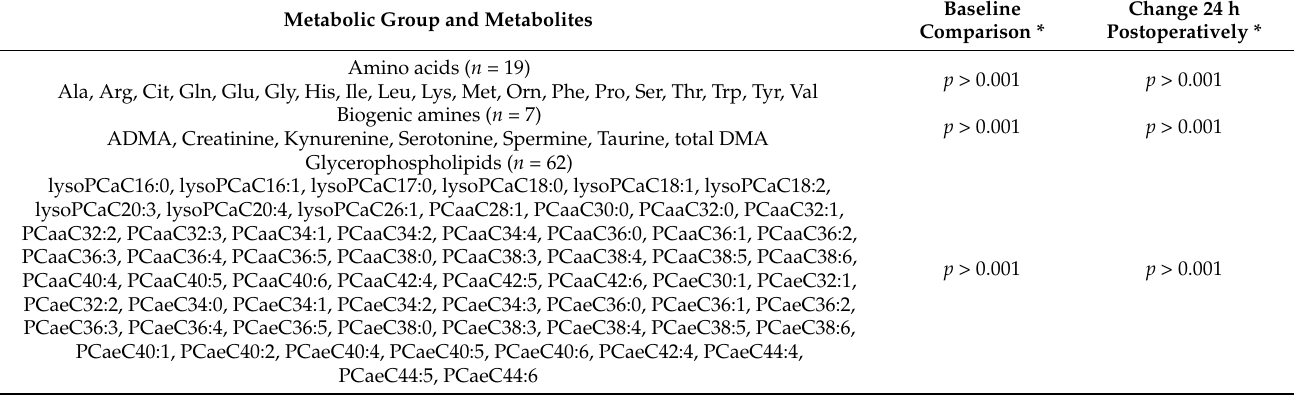
Table 2. Complete list of metabolites included in final analysis and summarized comparison of their baseline and postoperative values between the RIPC and sham